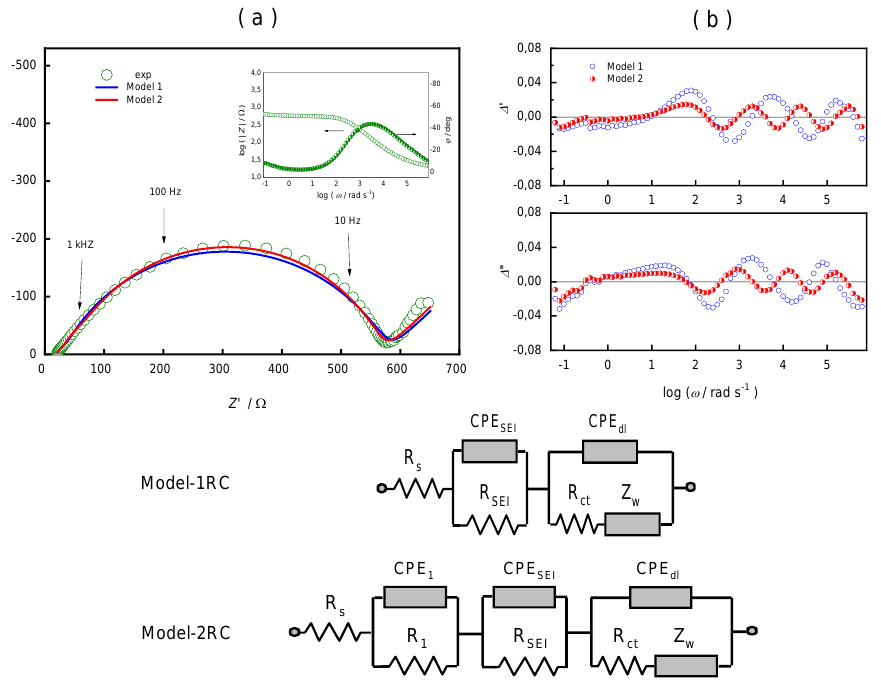
Figure 15. Time-dependance PEIS spectra of HCSi20 cell at +0.05 V in ( a ) Nyquist plot, ( b ) residu- als.